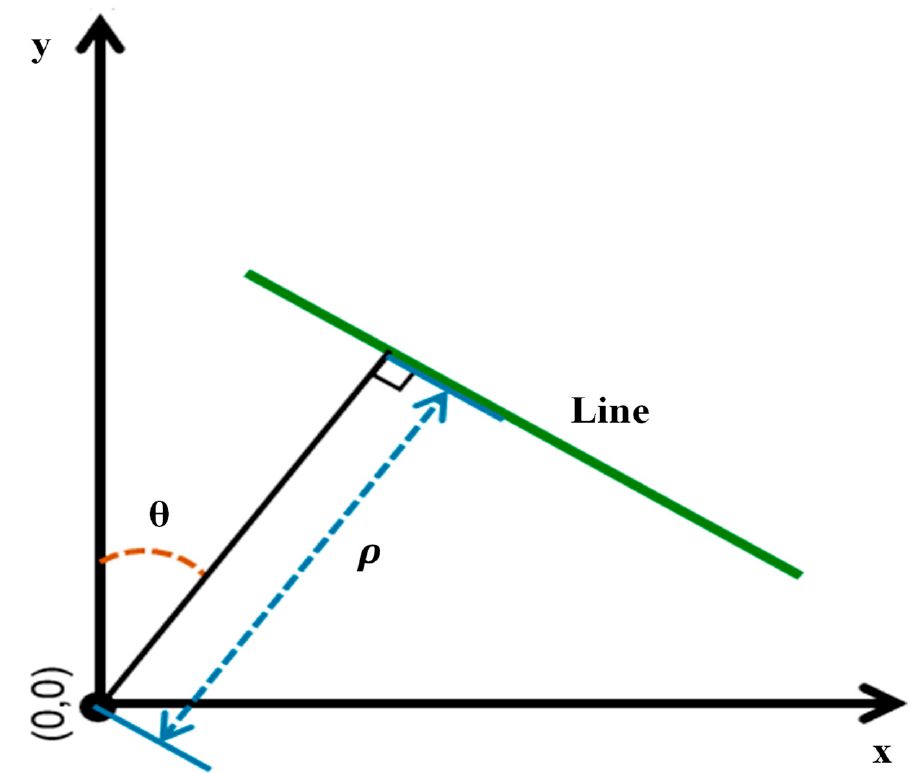
Figure 9. Schematic representation of ρ and θ .